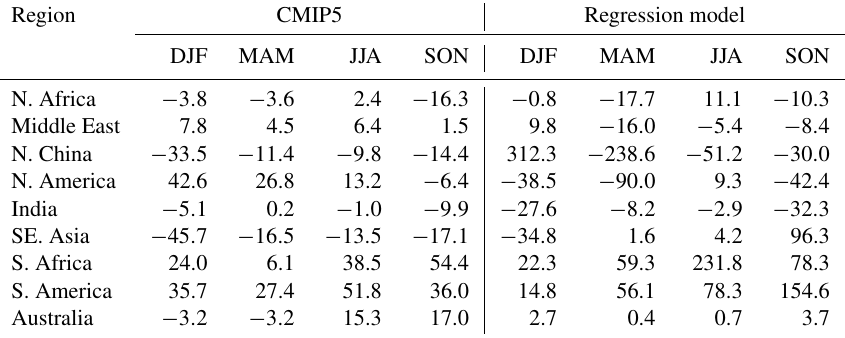
Figure 5. Correlations (color) between regional averaged time series from CMIP5 DOD and MODIS DOD from 2004 to 2016 for four seasons. Numbers on the x axis denote each model (1–7) and multi-model mean (8). Correlations significant at the 90% confidence level are marked by a star and significance at the 95% confidence level by two stars. Table 3. Changes of DOD in the late half of the 21st century (2051–2100; RCP8.5 scenario) from the historical condition (1861–2005) projected by the CMIP5 multi-model mean (second to fifth columns) and the regression model (sixth to ninth columns) in nine regions. Changes of DOD are shown as a percentage with reference to CMIP5 multi-model historical run. Note that in some regions the projected change by the regression model is quite large (i.e., greater than ± 100%), largely due to the underestimation of CMIP5 historical run in these regions. Region CMIP5 Regression